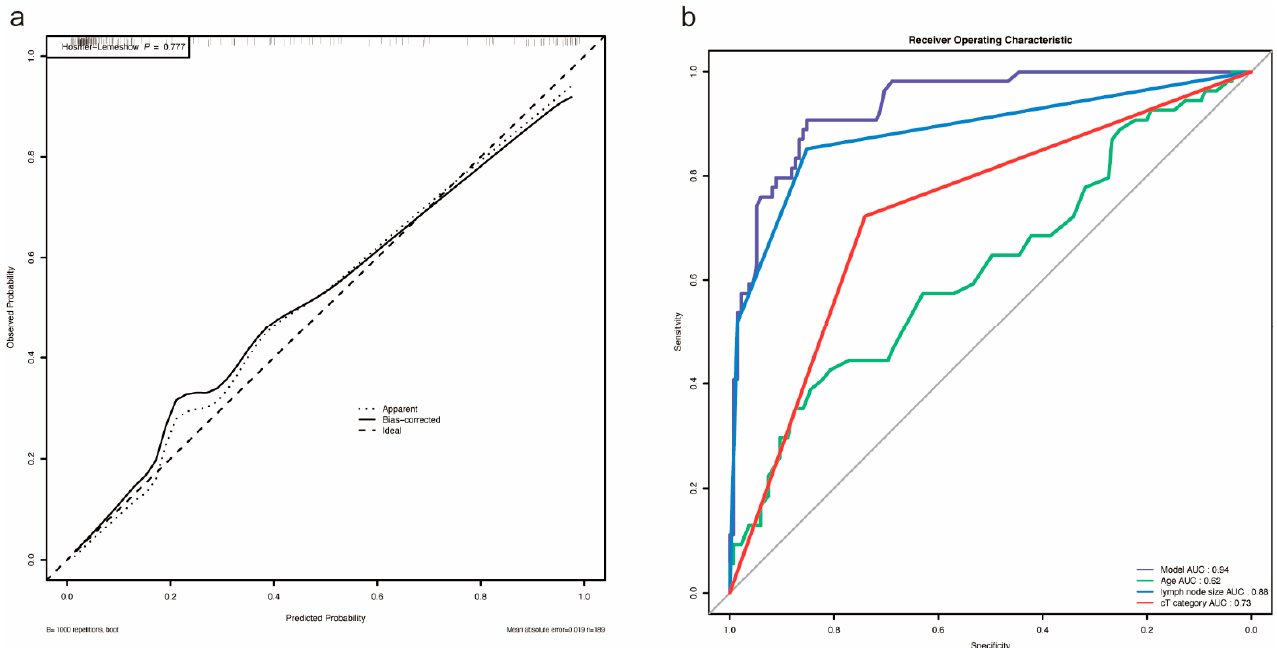
Figure 3. ( a ) Calibration curve for nomogram. ( b ) ROC curve. The area under AUC for the model was 0.94.